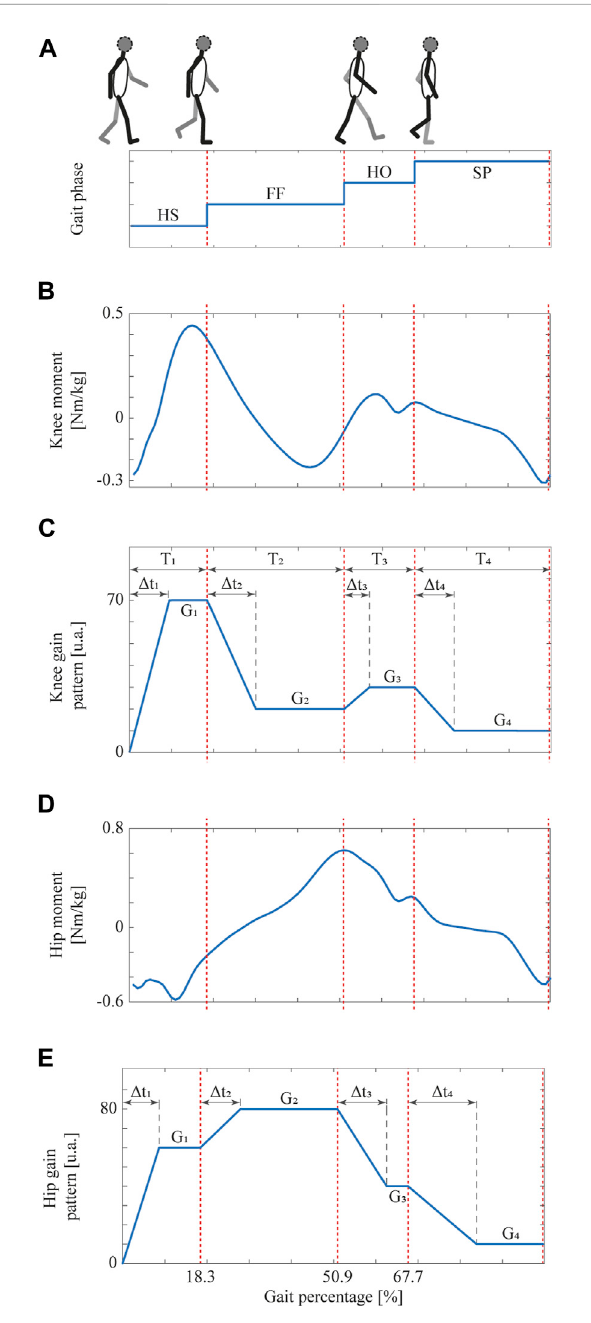
FIGURE 8 The gait phase detected schematic during the walking activity, taking into account the time spans ( Δ t i ) for each gait phase.; (A) Gait phases detected by means of the inertial-based partitioning method. (B) Kneeand (D) Hipmomentthroughoutthegaitcycleinhealthy subjects at a comfortable speed (Fukuchi et al., 2018). Also, gain patterns based on the (C) knee and (E) hip moment which ensures smooth transitions between gait phases. Adapted from (Villa-Parra et al.,